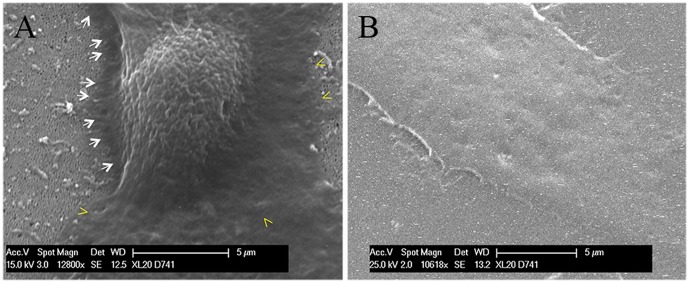
SEM imaging of NIH-3T3 cells on AAO-NTPLL (A) and PPLL (B).Arrows and arrowheads show cell interactions with the substrate.